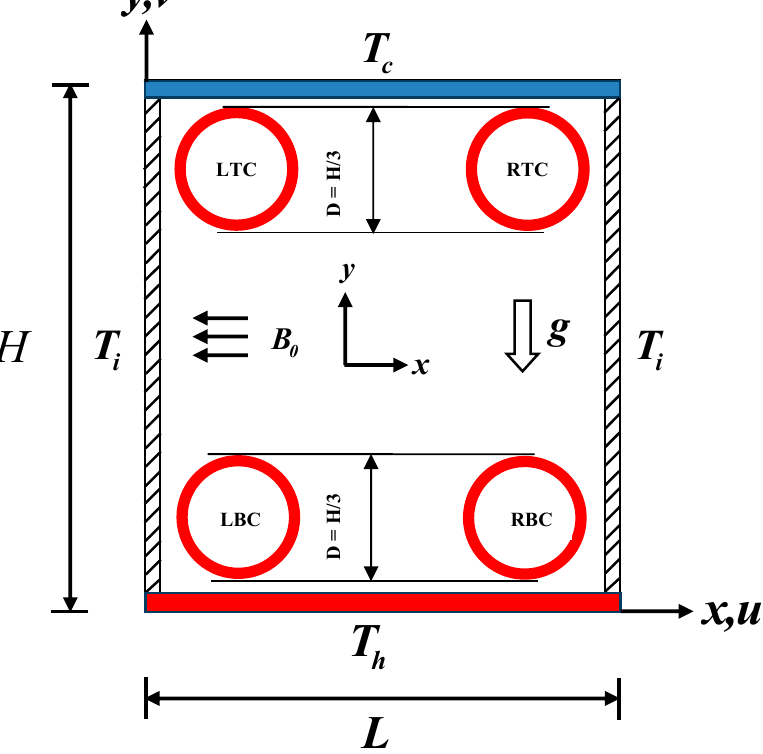
Figure 1. Schematic model of the present study.